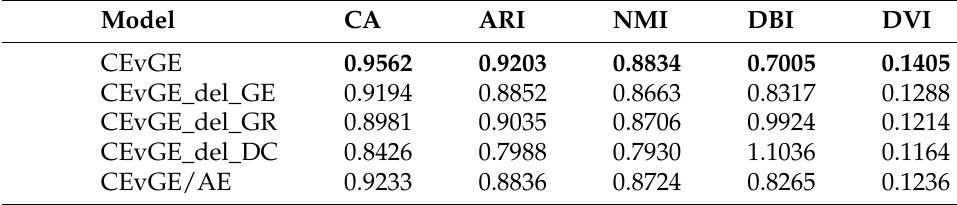
Table 11. Ablation studies on MNIST data